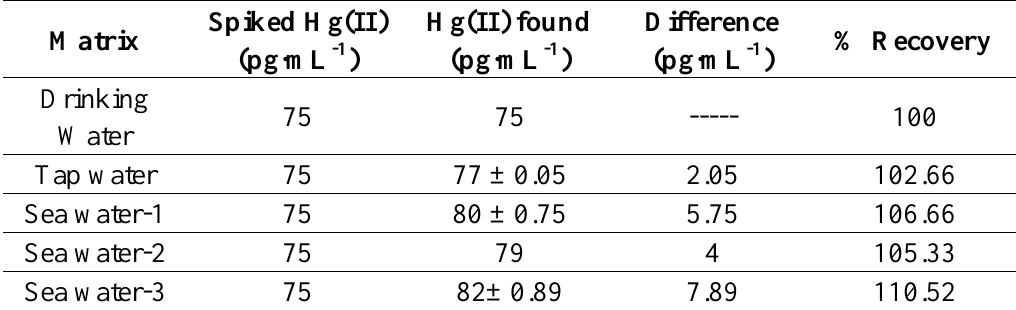
Table 3. Recovery studies in real samples using free AlOx/HRP- methanol assay. The assay was carried out in 0.1 M PB, pH 7.5 at 35 ° C in 96 well plate formats. 75 pg . mL −1